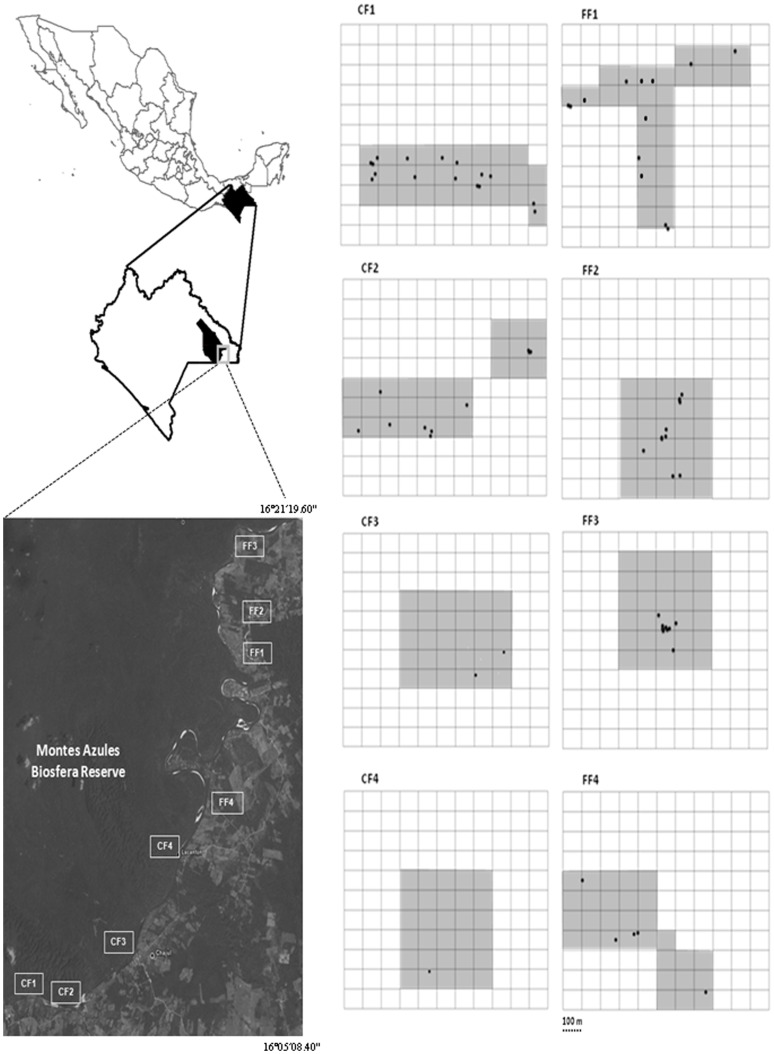
Continuous forest sites and forest fragments studied in the Lacandona rainforest, Mexico.The location of each sleeping site of spider monkeys (dots) within the 30 ha of sampling area (gray shaded areas) area indicated. These areas were divided in 1-ha plots to estimate the spatial distribution of sleeping sites within each study area.